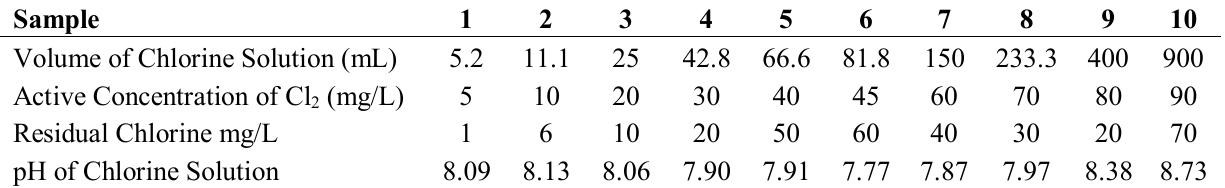
Table 4. Range to determine the treated wastewater demand in